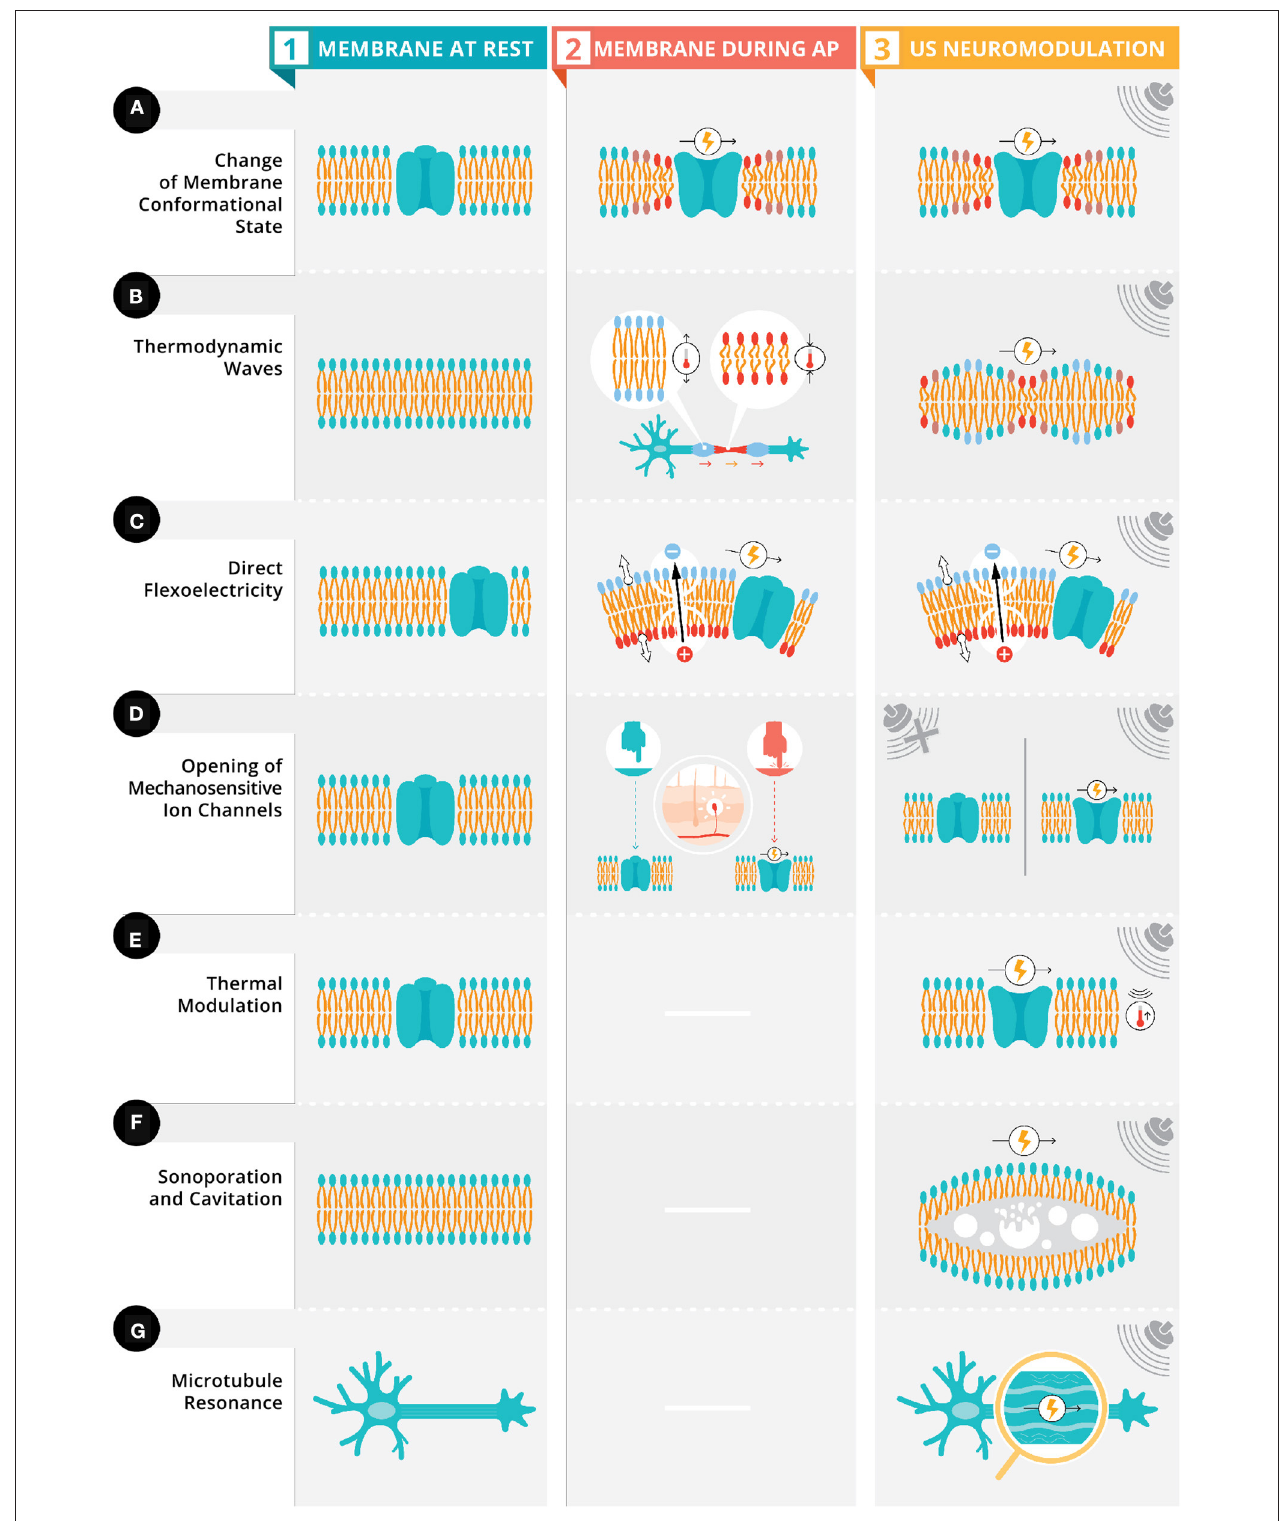
FIGURE 2 | Proposed ultrasonic stimulation’s mechanisms for neuromodulation. Depicted in column 1 are six neuronal membranes (four with an ion channel [rows A,C,D,E ] and two neuronal membranes [rows B,F ] with polar lipid bilayer) and a neuron with the microtubules highlighted (row G ). Depicted in column 2,